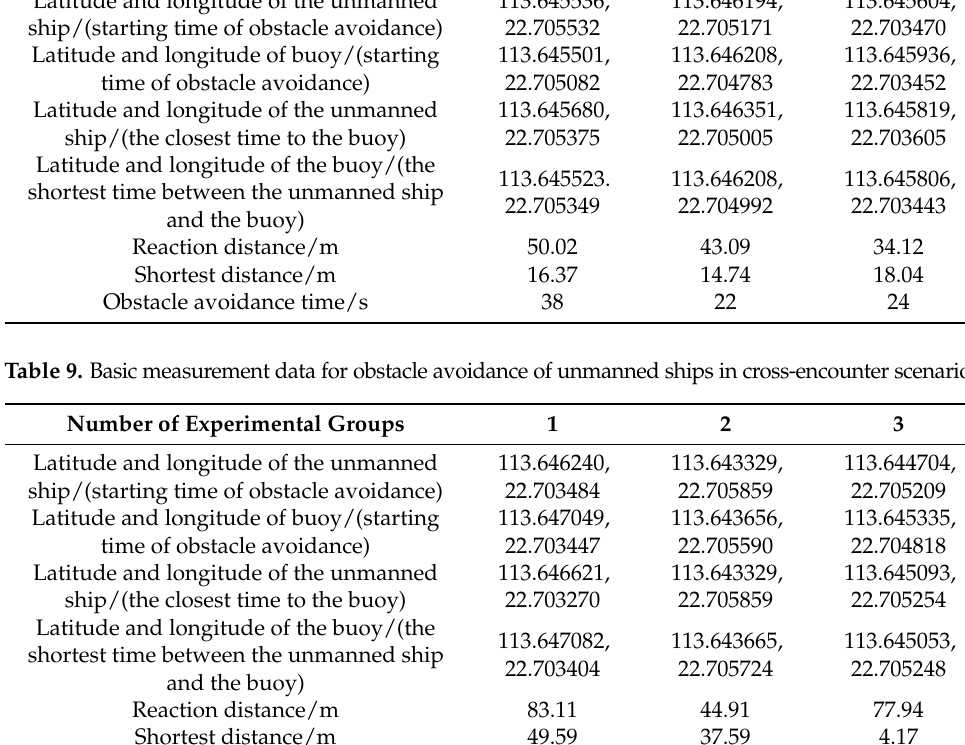
Table 8. Basic measurement data for obstacle avoidance of unmanned ships in encounter scenarios. Number of Experimental Groups